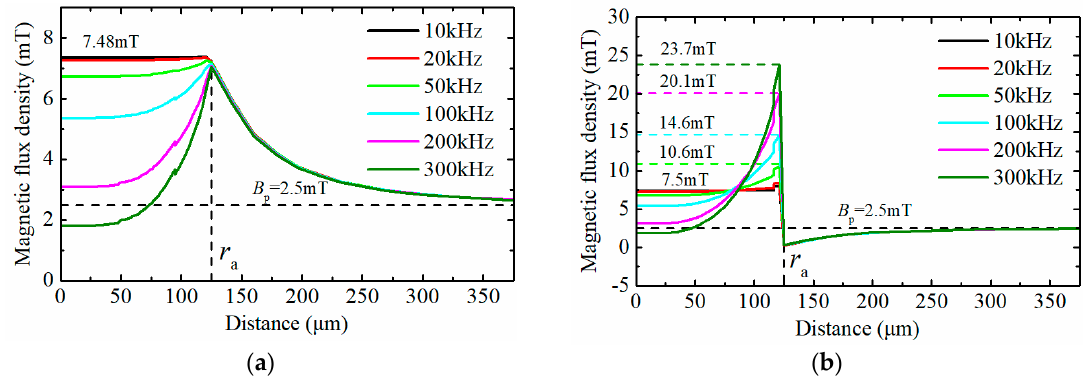
Figure 5. The distribution of magnetic flux density around the particle under different field frequencies. ( a ) The distribution of magnetic flux density along the x axis; ( b ) The distribution of magnetic flux density along the y or z